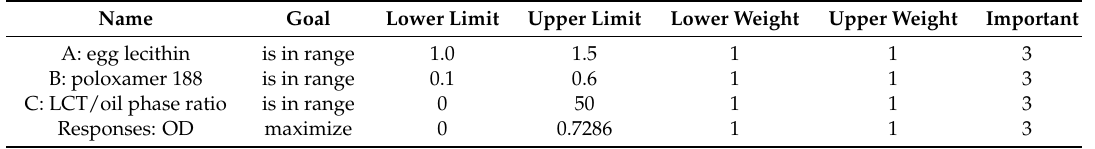
Figure 1. Response surface plot. ( a ) The effect of interaction of the egg lecithin and poloxamer 188 on OD value; ( b ) The effect of interaction of the egg lecithin and LCT/oil phase ratio on OD value; ( c ) The effect of interaction of poloxamer 188 and LCT/oil phase ratio on OD value. Table 5. Constraints of factors and responses for optimization.